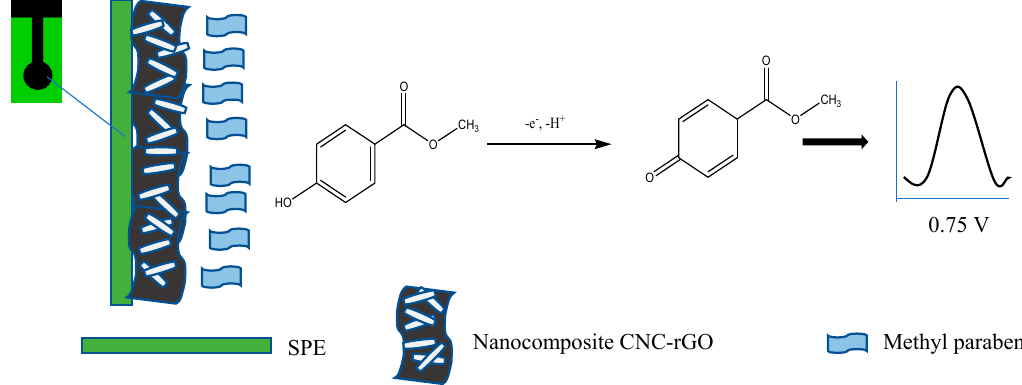
Figure 4. Schematic diagram of the sensor fabrication and MP detection.